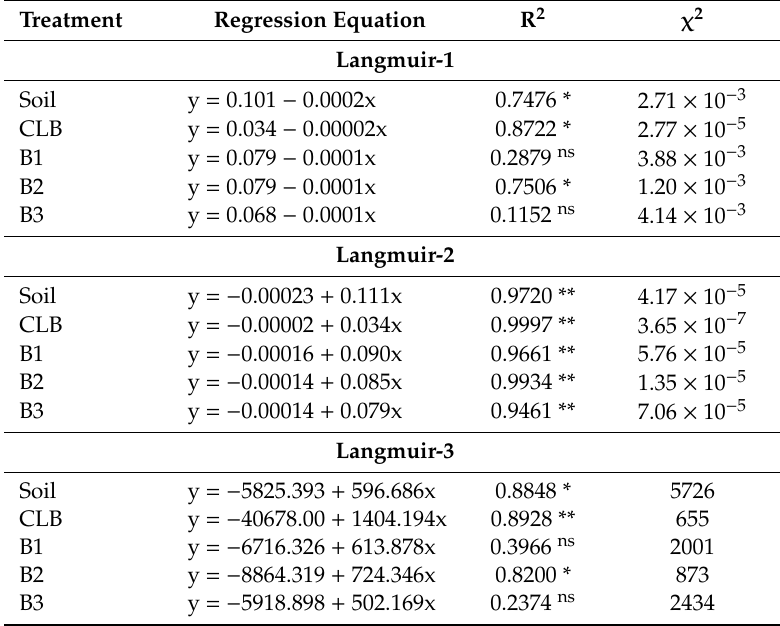
Table 11. Regression equations, Coe ffi cient of determination (R 2 ), and Chi-square analysis ( χ 2 ) for the fit of the Langmuir type 1, 2, and 3 isotherms to the nitrogen adsorption data of the treatments.